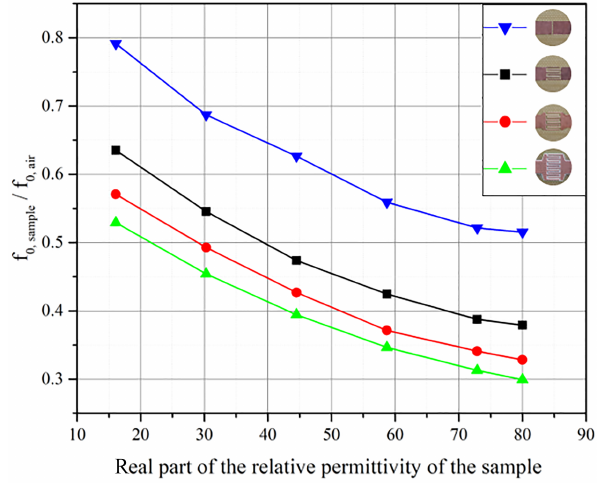
Figure 11. Measuring an increasing sample permittivity with dif- ferent split